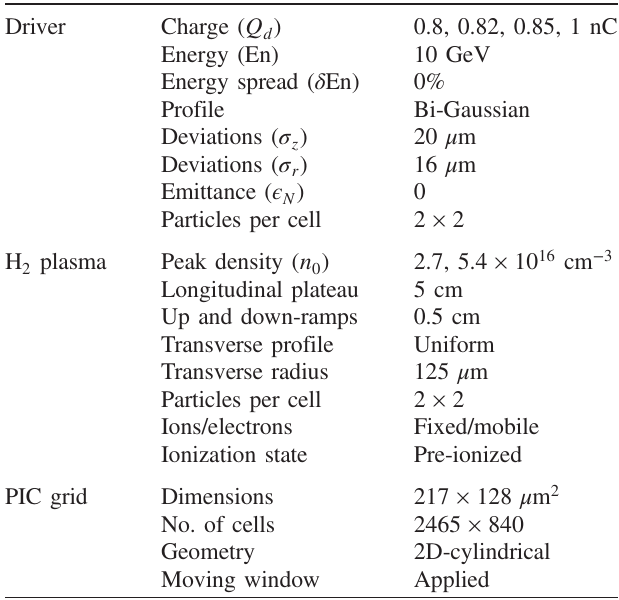
slice is capable of ionizing He atoms. Only for the driver with 1 nC charge do the slices closer to its tail, which have